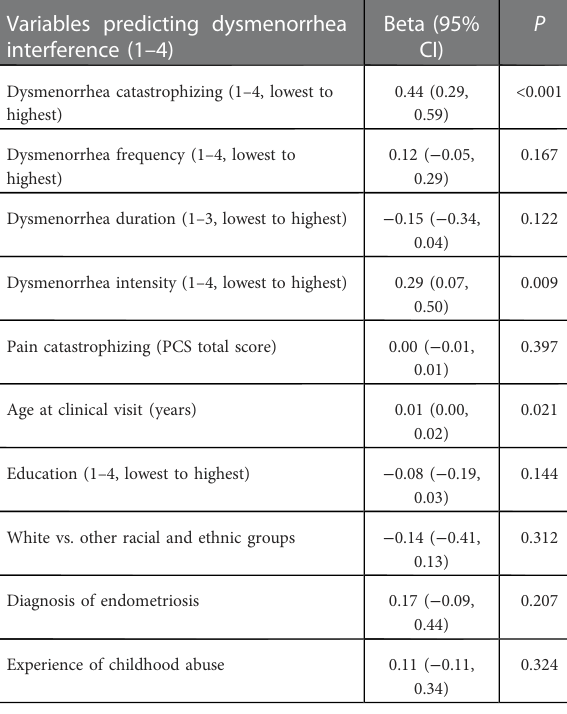
TABLE 4 Multiple linear regression model for the covariates-adjusted association between dysmenorrhea catastrophizing and dysmenorrhea interference a .